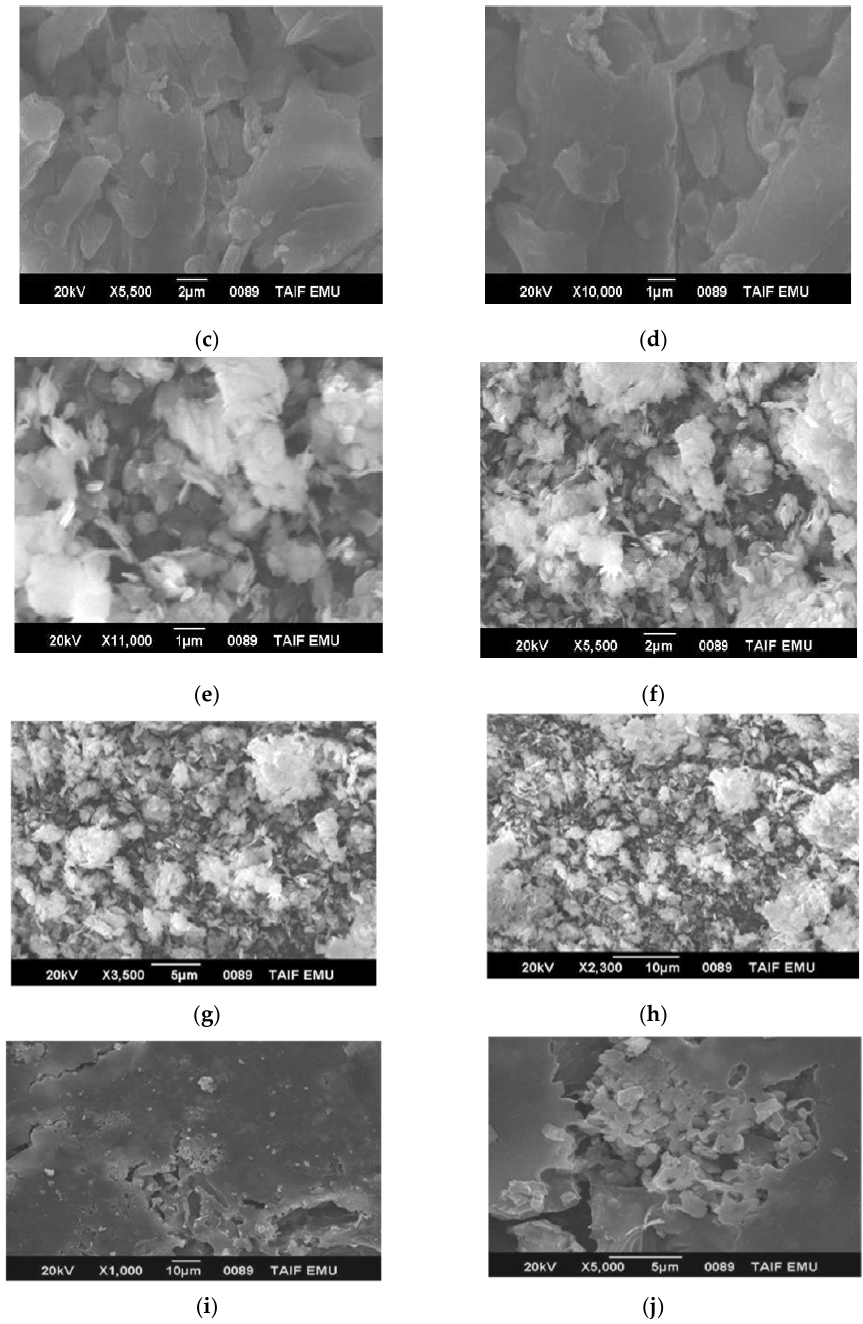
Figure 8. SEM micrographs at different magnifications. ( a – d ) Cellulose nanoparticles, ( e – h ) ZnO nanoparticles, ( i ) electrolyte paste, and ( j ) electrolytic paste without ZnO.